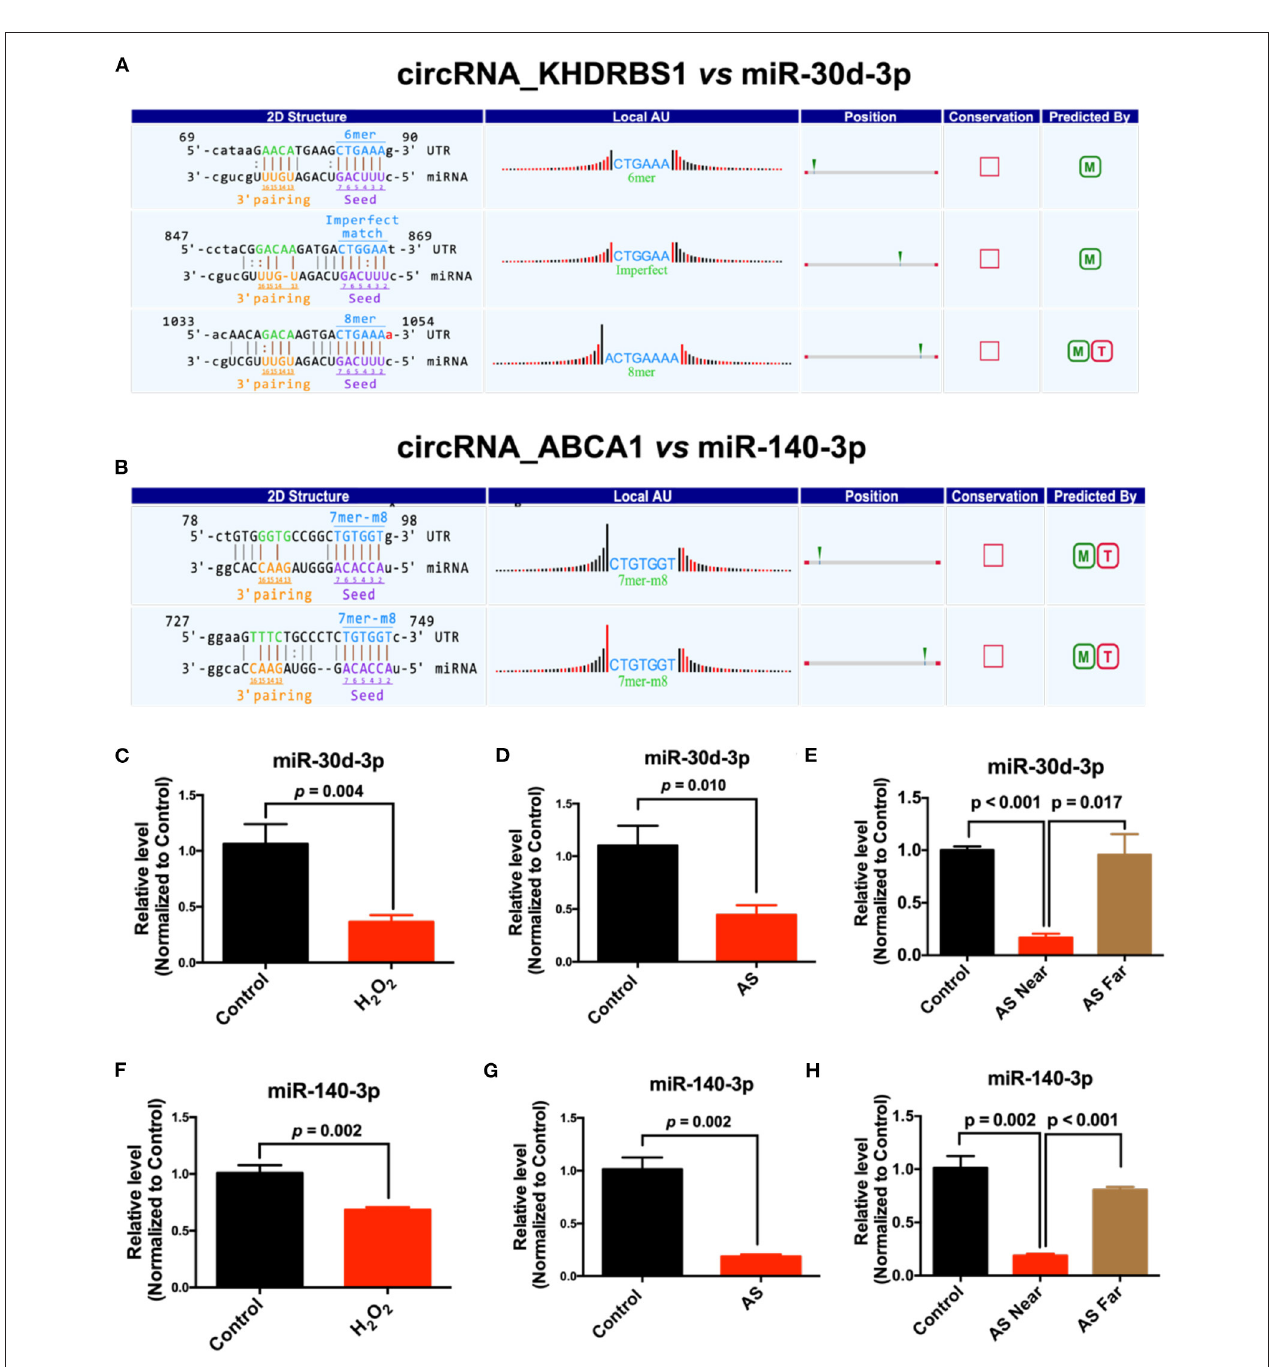
FIGURE 5 | Prediction and validation of complementary microRNAs of differentially expressed circRNAs. (A) The binding sites and 2D structure of circRNA KHDRBS1 with miR-30d-3p; (B) The binding sites and 2D structure of circRNA ABCA1 with miR-140-3p; (C–E) Expression of miR-30d-3p and miR-140-3p in MAECs induced by H 2 O 2 and AS aorta, n = 3–6; (F–H) Expression of miR-140-3p in MAECs induced by H 2 O 2 and AS aorta, n =